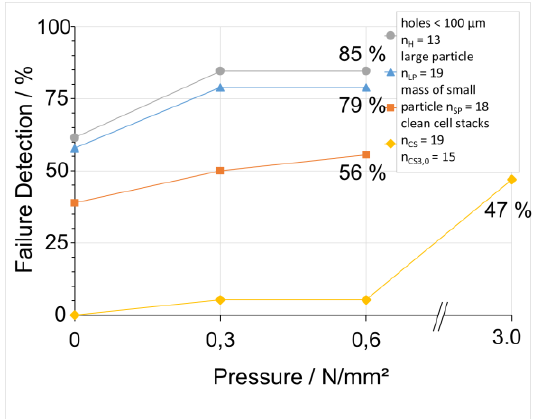
Figure 5. Defect detection rates of the clean reference cell stacks without forced defects (yellow curve; n CS = 19; n CS3,0 = 15) are compared with defect detection rates of cell stacks that had various particle contaminations, including one large particle (blue curve; n LP = 19), mass of small particles (red curve; n SP = 18), and holes (gray curve; n H = 13).